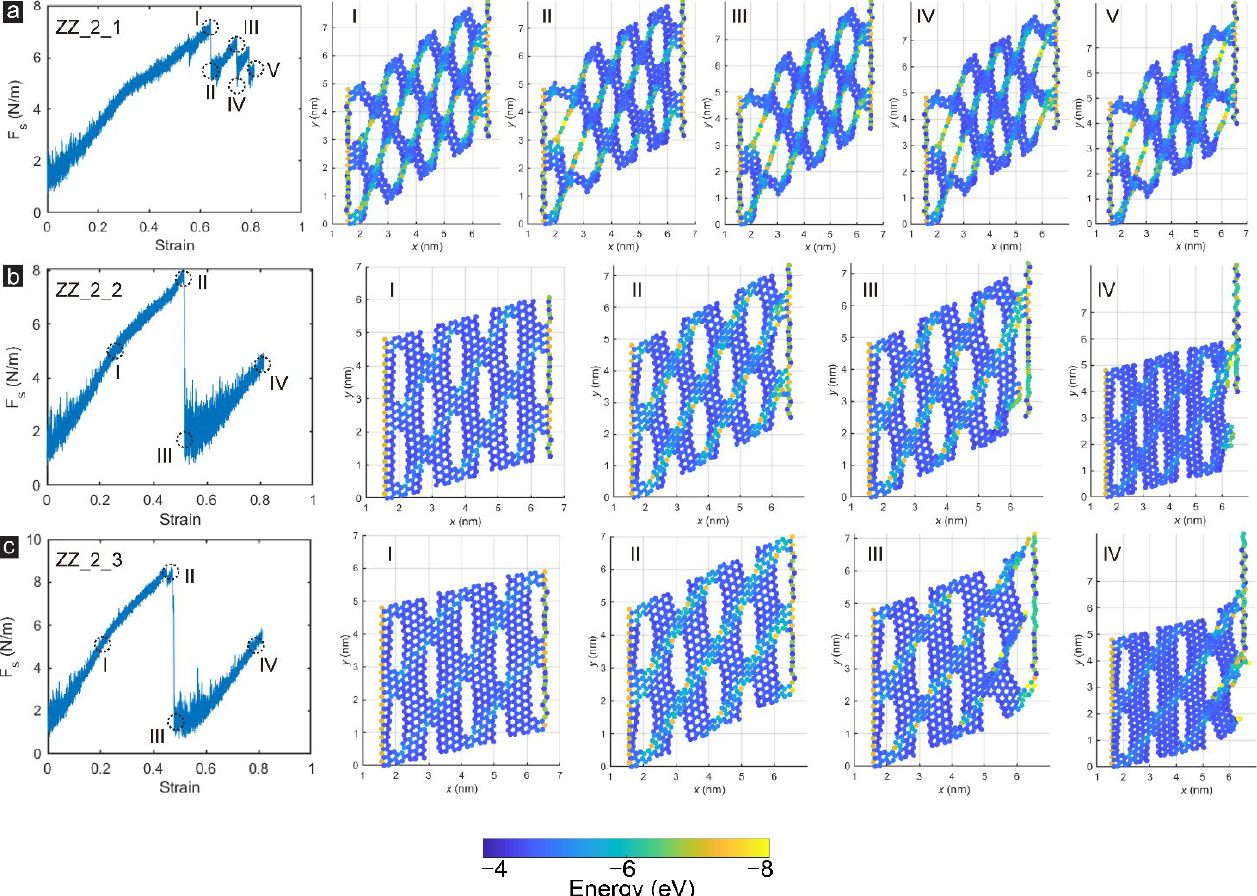
Figure 5. The snapshots of the microstructural damage processes and failure characteristics of zigzag-incised GK membrane: Sample ( a ) ZZ_2_1; ( b ) ZZ_2_2 and ( c ) ZZ_2_3.